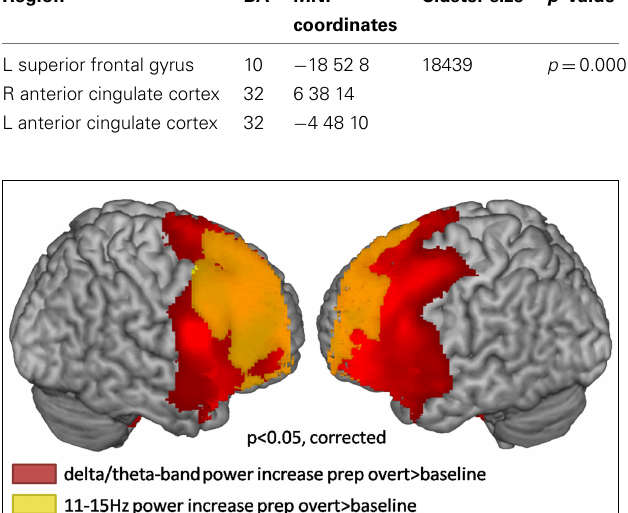
Table 4 | Local maxima of sources showing a power decrease (beta band) for preparation for overt vs. covert